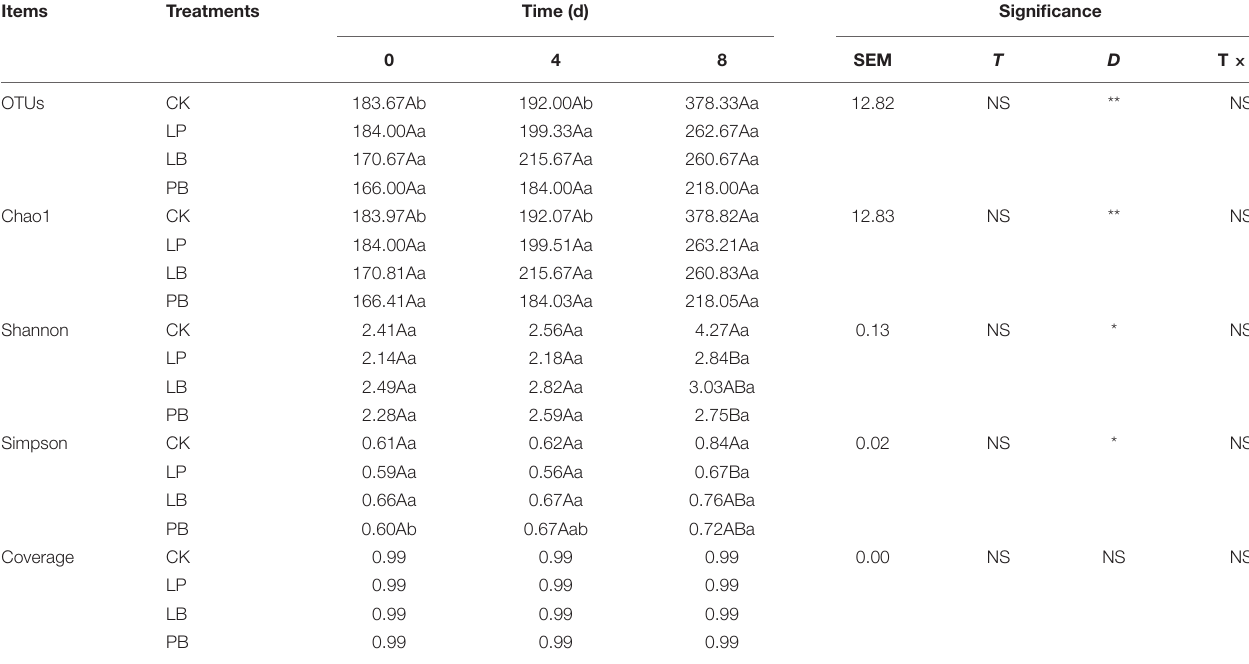
TABLE 4 | Effects of additives and days of aerobic exposure on bacterial alpha diversity of Leymus chinensis silage. Items Treatments Time (d)